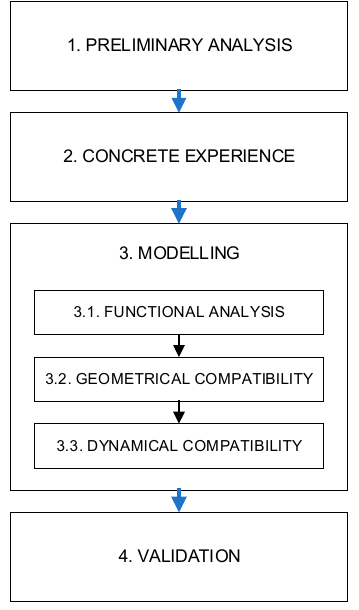
Figure 3. Scheme of the research approach.